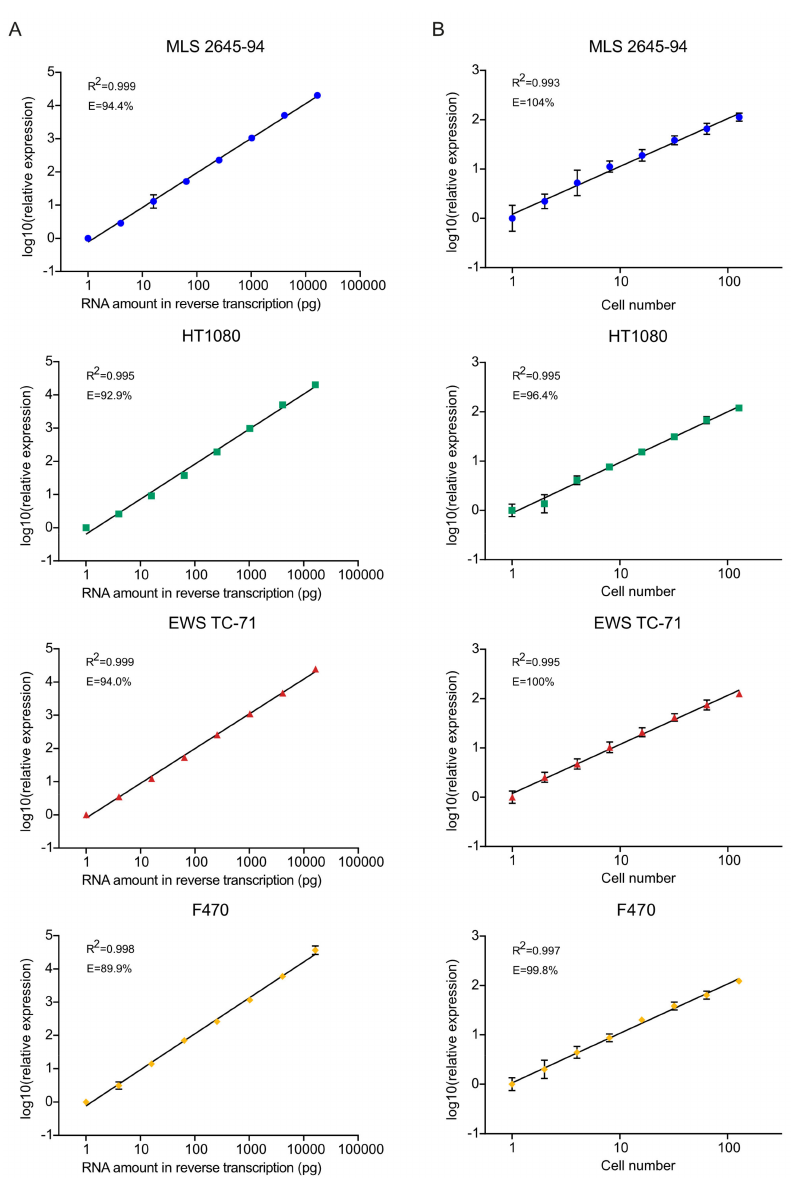
Figure 2. Total polyadenylated RNA analysis. ( A ) Total polyadenylated RNA analysis of di ff erent amounts of total RNA extracted from myxoid liposarcoma (MLS) 2645-94, HT1080, Ewing sarcoma (EWS) TC-71, and F470. Standard curves ranged from 16.4 ng to 1 pg with dilution steps of four. The relationship between relative quantity and RNA amount was tested with linear regression. Mean ± SD is shown, n = 3–5. PCR e ffi ciencies (E) and R 2 values are indicated. ( B ) Total polyadenylated RNA analysis of a di ff erent number of cells sorted from MLS 2645-94, HT1080, EWS TC-71, and F470. Standard curves ranged from 128 cells to single cells in steps of two. The relationship between relative quantity and cell number was tested with linear regression. Mean ± SD is shown, n = 4–7 ( > 1 cell), n = 6–14 (one cell). PCR e ffi ciencies (E) and R 2 values are